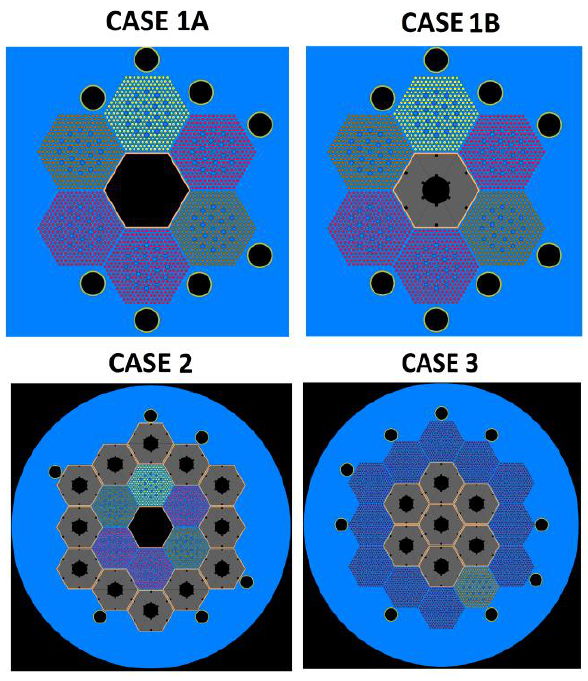
Fig. 1. The core configurations performed at the LR-0 reactor. CASE 1A and CASE 1B, CASE 2 and CASE